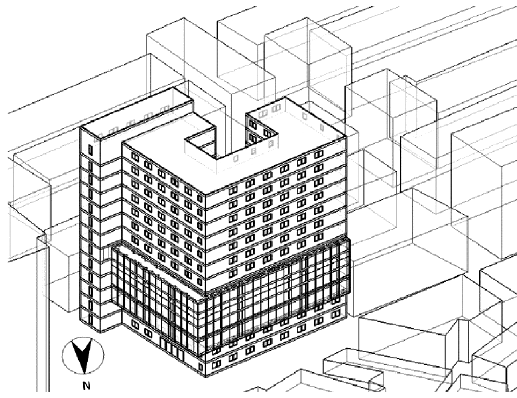
Figure 17. Addition of window elements, insulating walls, and